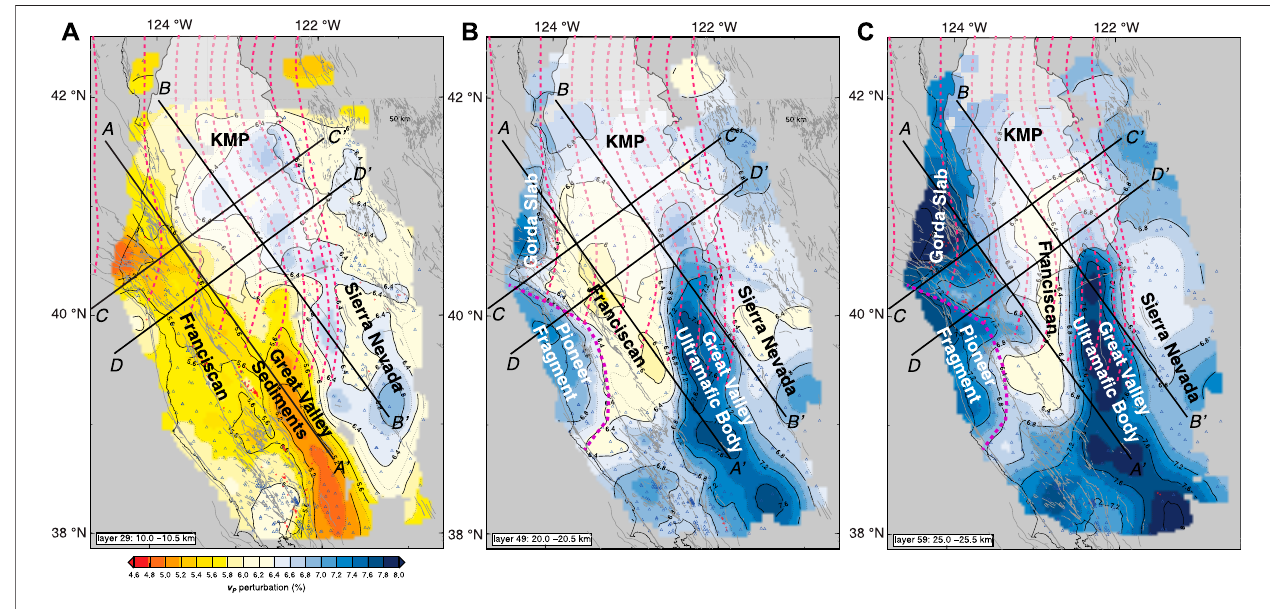
FIGURE 8 | Seismic tomography results in map view at different crustal levels (10 km, 20 and 25 km) (Furlong et al., 2021). The Great Valley body, the Pioneer fragment, the Gorda slab, the Franciscan complex and the Sierra Nevada are labeled. Pink dashed lines are 10 km slab contours (Slab2, Hayes 2018). Lines (A – A 9 , B – B 9 , C – C 9 , D – D 9 ) indicate the locations for the cross sectional pro fi les shown in Figure 9